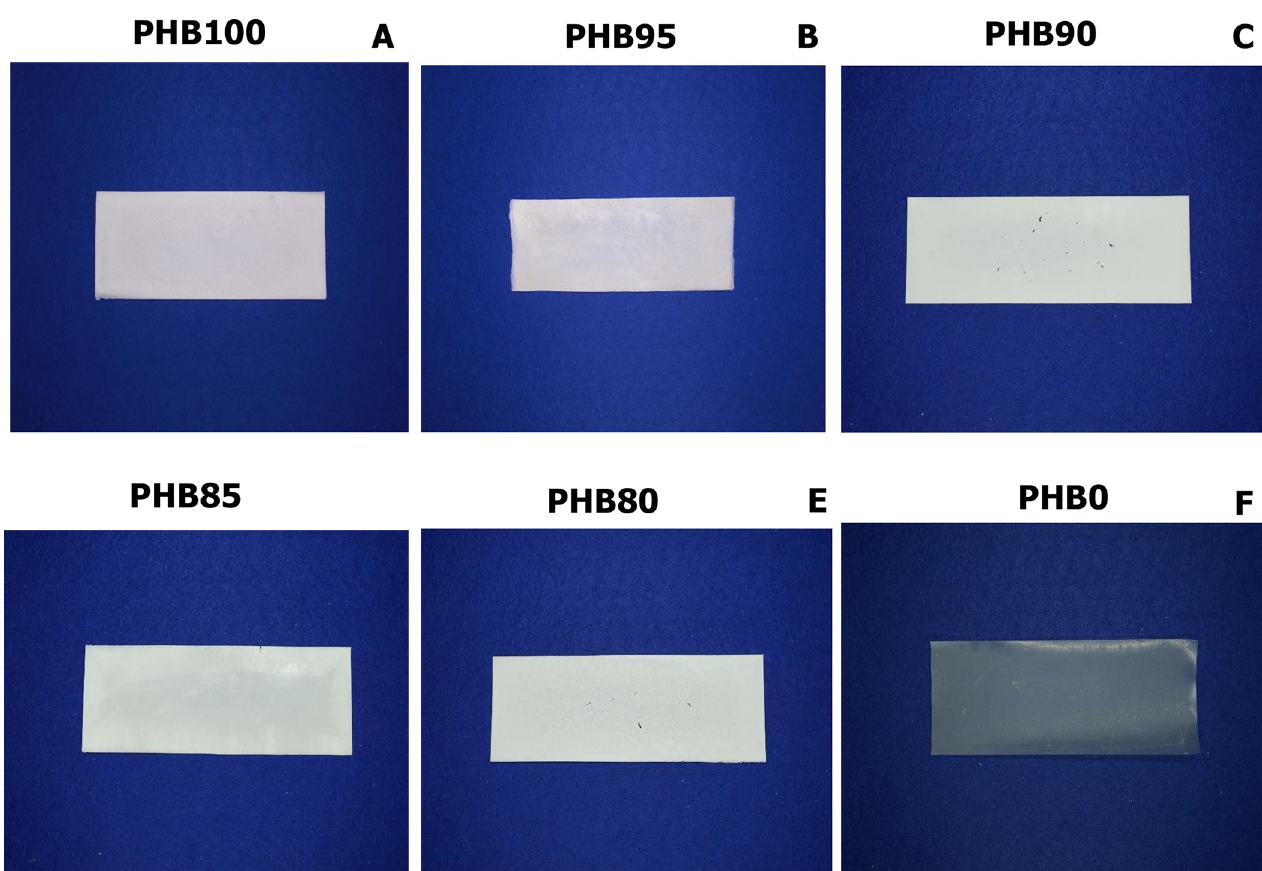
Fig 9. Appearance of PHB/esterified PALF-MCC laurate biocomposite films.